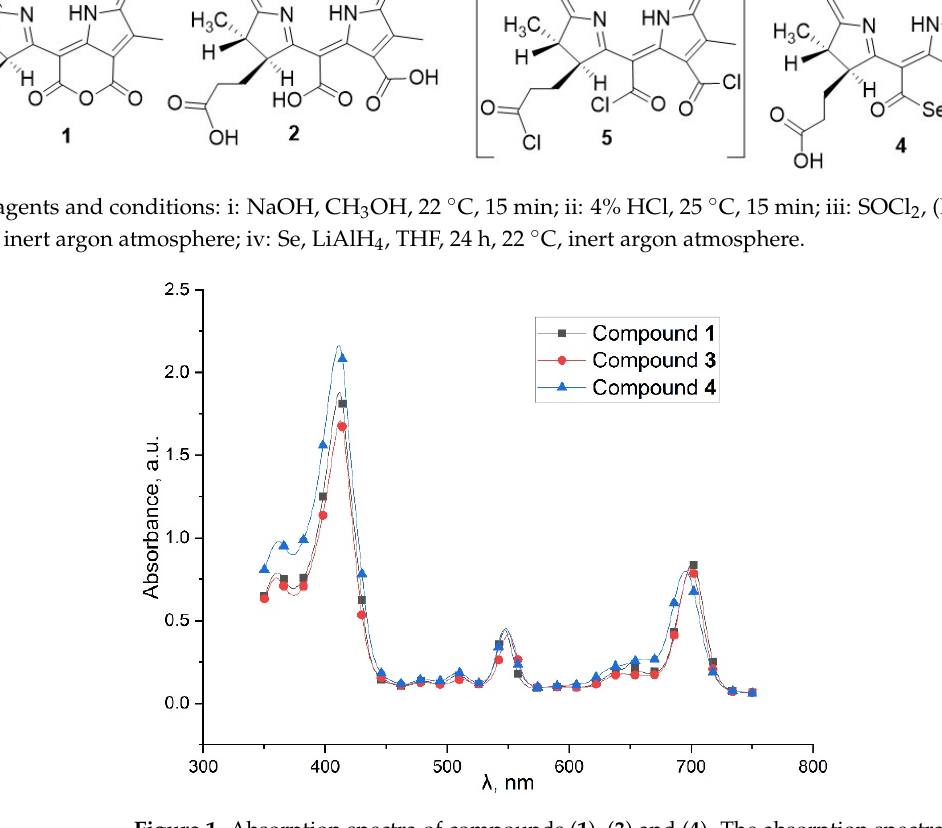
Figure 1. Absorption spectra of compounds ( 1 ), ( 3 ) and ( 4 ). The absorption spectra were obtained at the same solution concentrations, with dichloromethane as a solvent.